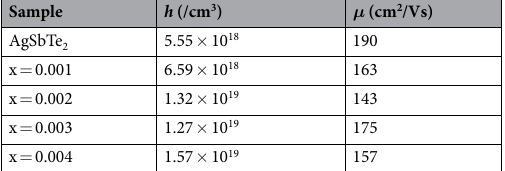
Table 2. Carrier concentration and the mobility of Ce-doped AgSb 1 − x Ce x Te 2